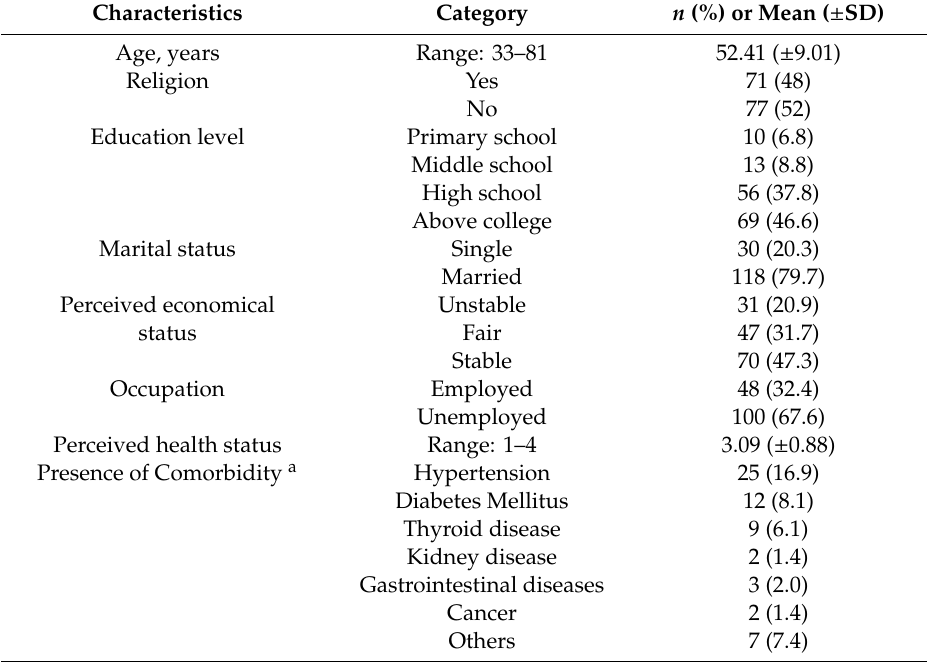
Table 1. Characteristics of participants ( n =